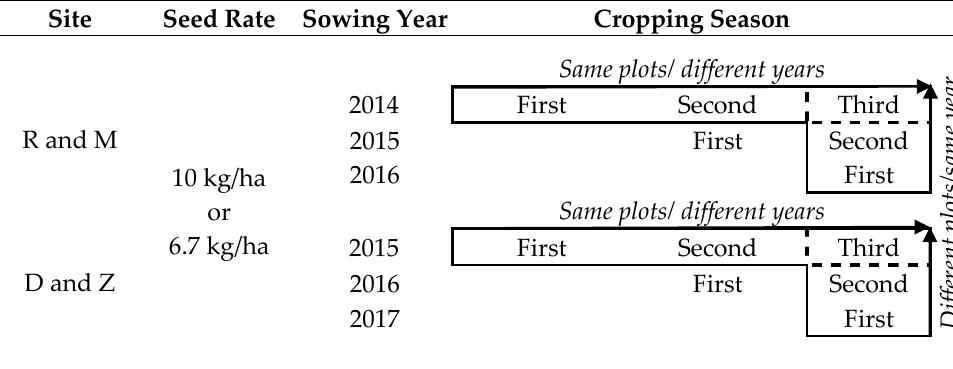
Table 2. Experimental factors, chronological progression of the cropping seasons and set-ups to follow weed density development ( → ).